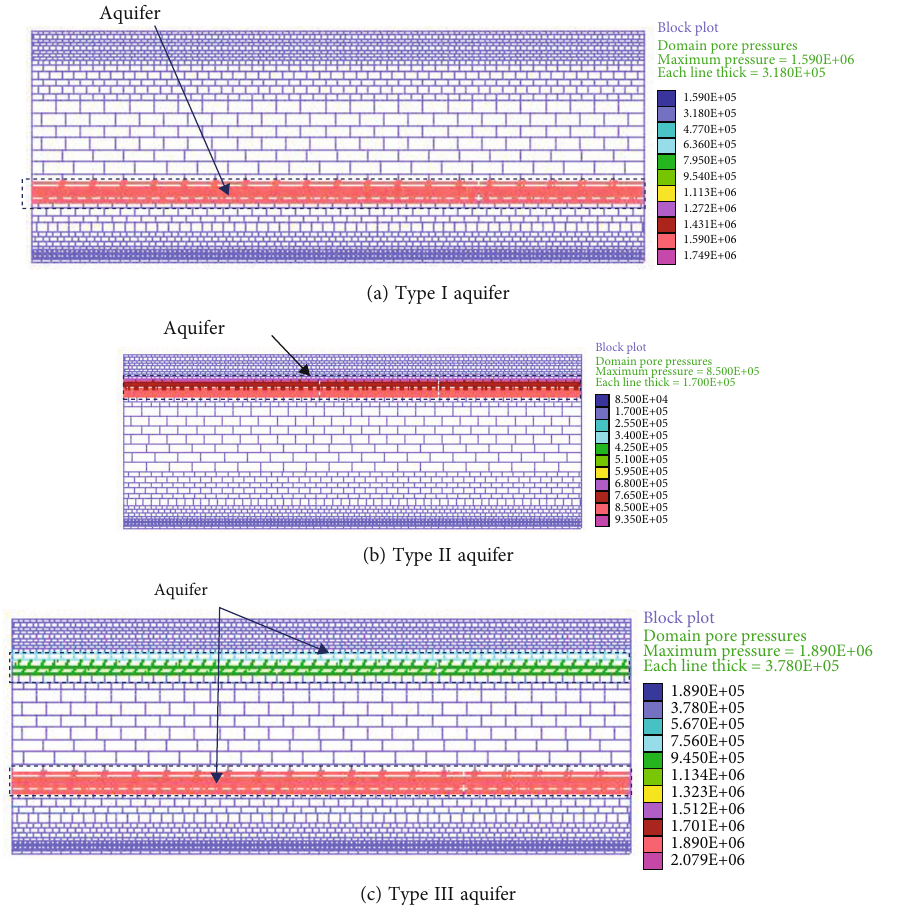
Figure 5: Numerical